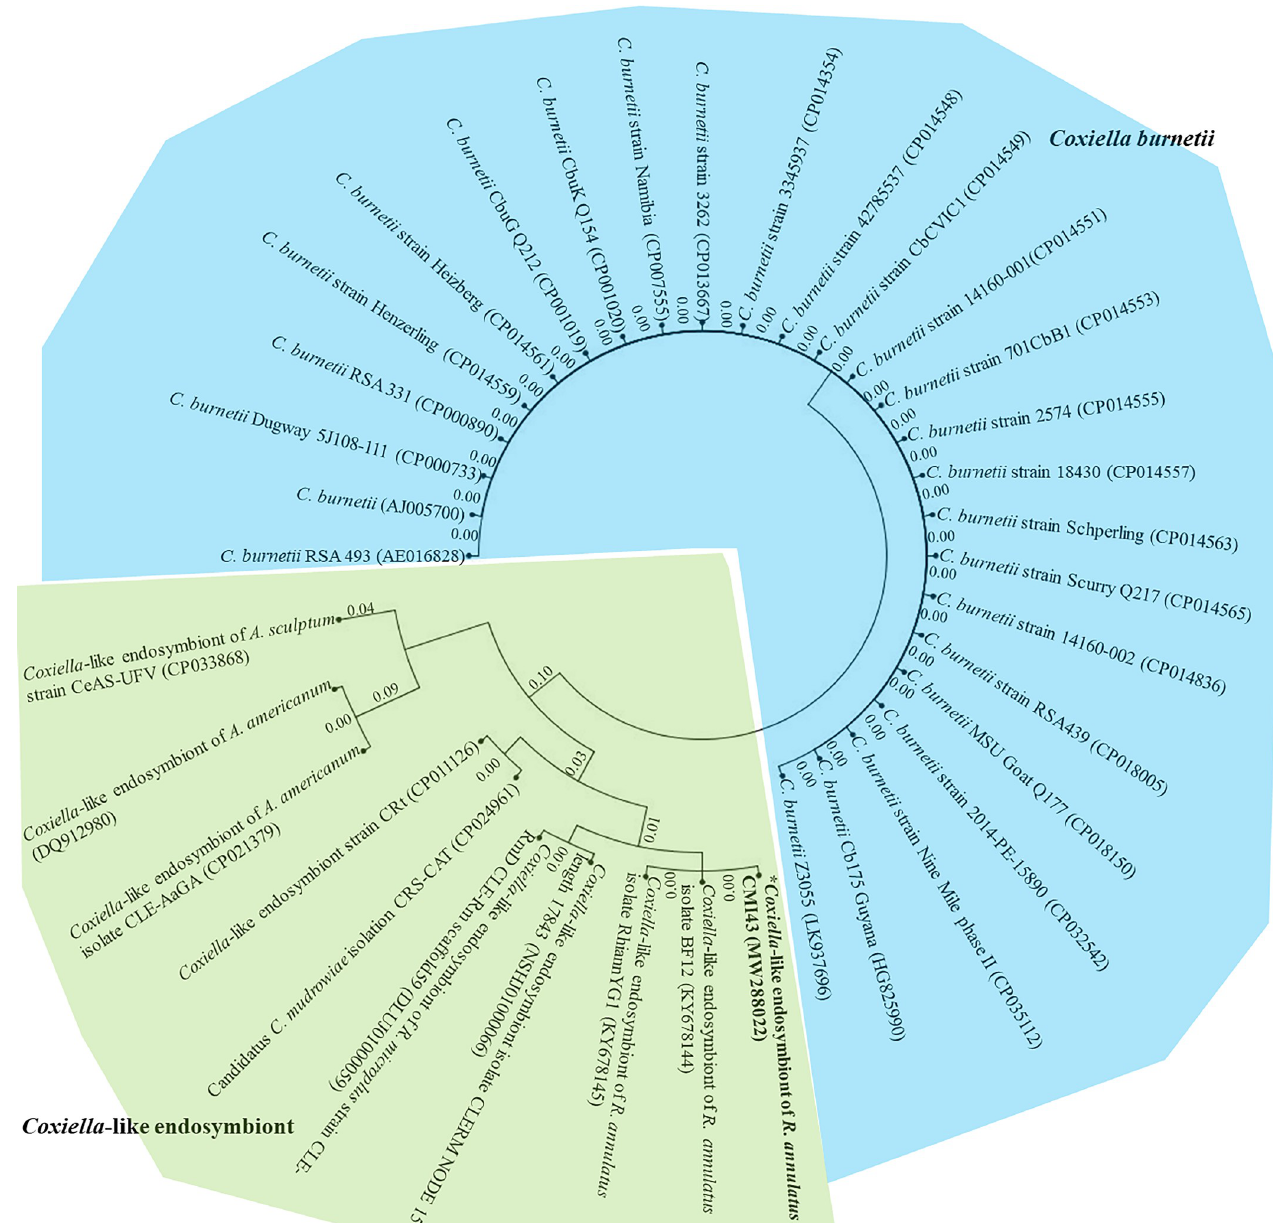
Fig 6. Phylogenetic cladogram of partial DnaK amino acid sequences of Coxiella sp. Phylogenetic tree showing the evolutionary divergence among the different partial DnaK animo acid sequences of Coxiella sp. The cladogram shows appropriate distances among C . burnetii (labeled with blue color) and CLEs (labeled green